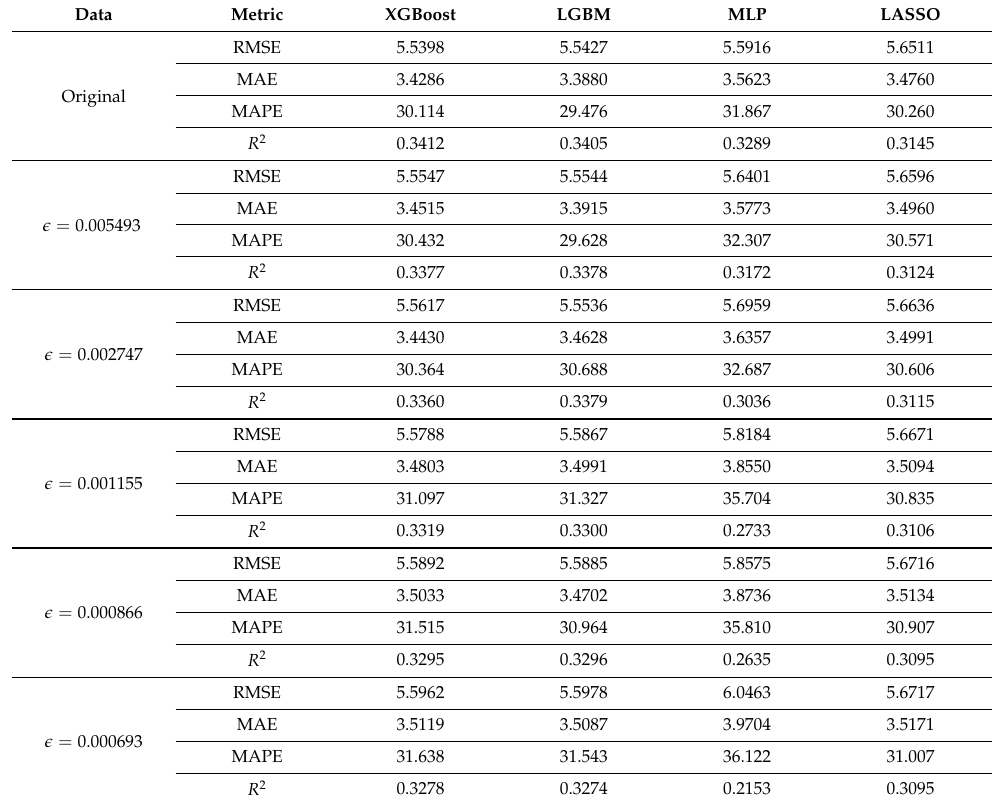
Table A2. Metrics results for each ML model trained with original data and sanitized